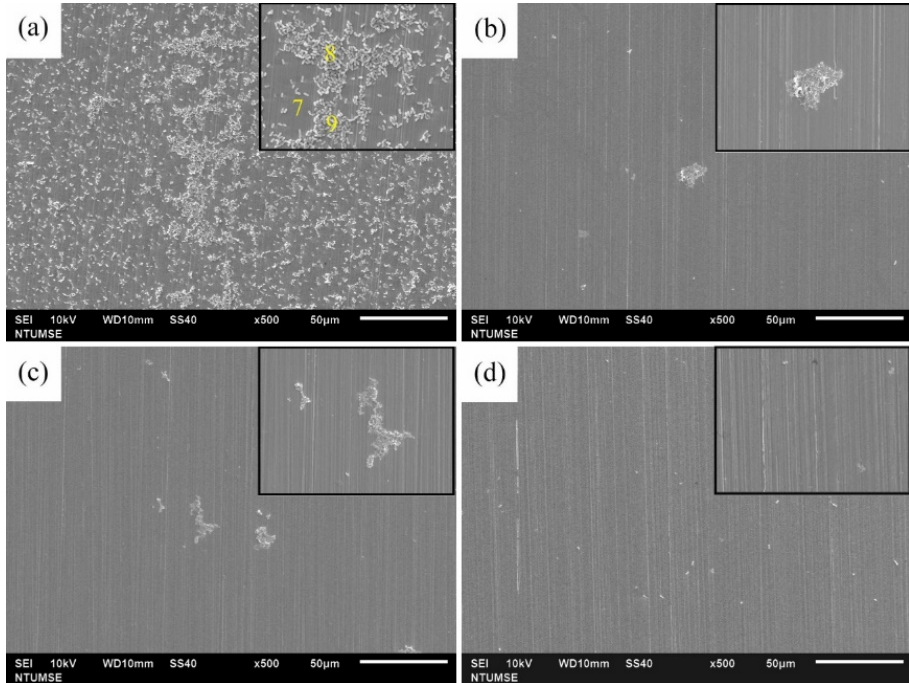
Figure 9. SEM images of the 304 SS surface after 12 h of exposure to ( a ) the uninoculated Zuoying medium, ( b ) TB, ( c ) 3TB, and ( d ) 5TB, presenting enlargements of areas with biofilm formation.